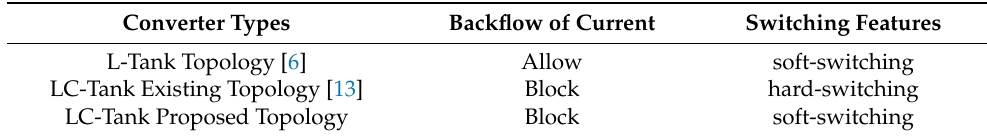
Table 1. Assessment of existing and proposed